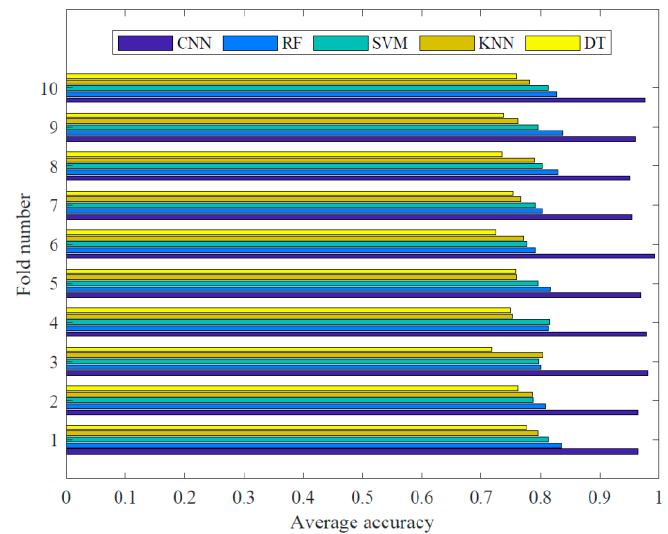
Figure 11. Comparisons of average accuracy in each fold of cross-validation